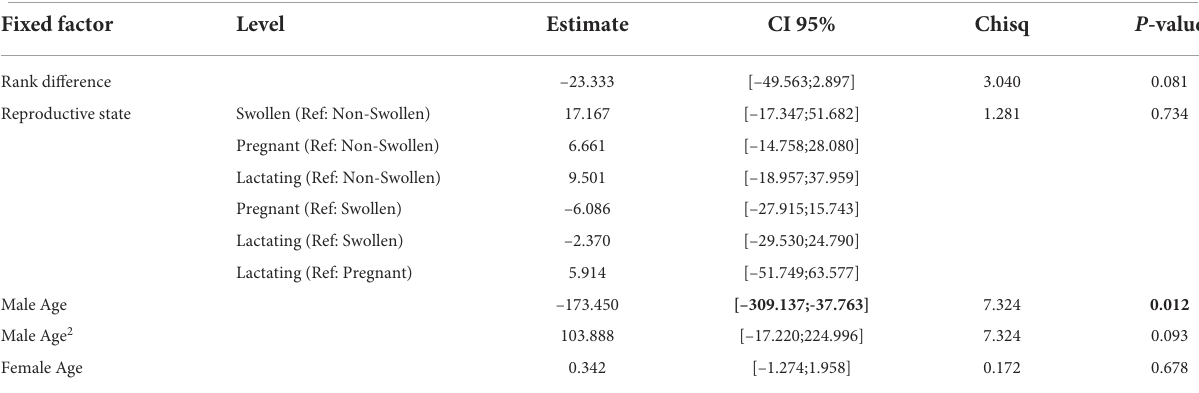
TABLE 2 Factors affecting the probability for a female to win a conflict against a male (Number of intersexual conflicts: